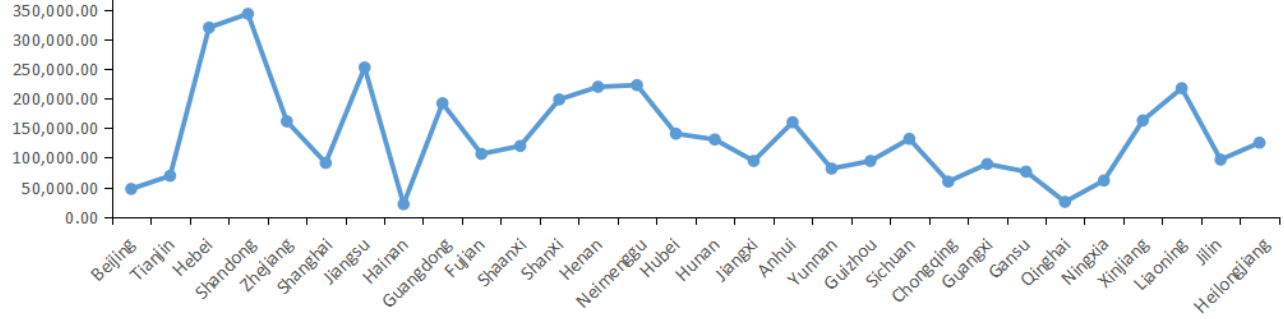
Figure 1. Proportionally distributed quantity/(million t) of 30 cities. Table 4. Allocation of total CO 2 control targets in China, 2025.